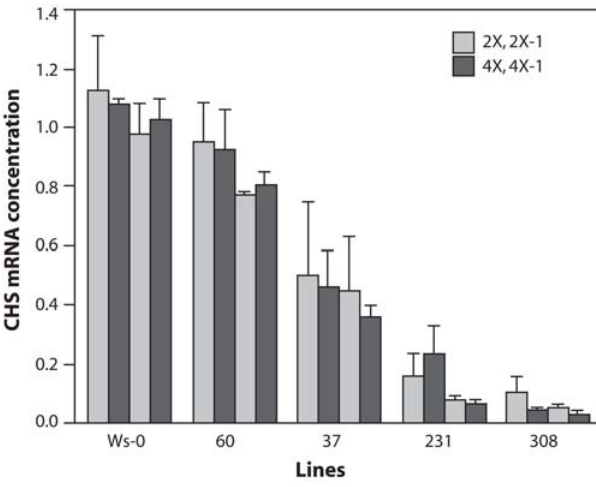
Figure 5. Quantification of CHS mRNA in transgenic seedlings. Seedlings were grown for 15 days on 6% sucrose medium and then sampled. SYBR Green Real-time RT-PCR was performed with the comparative threshold method, using 18s rRNA as endogenous control. The Y-axis displays the mean of three technical replicates in each of two biological replicates. Genotype is indicated in X-axis. In the legend: 2x and 2x-1 is diploid, 4x and 4x-1 tetraploid.